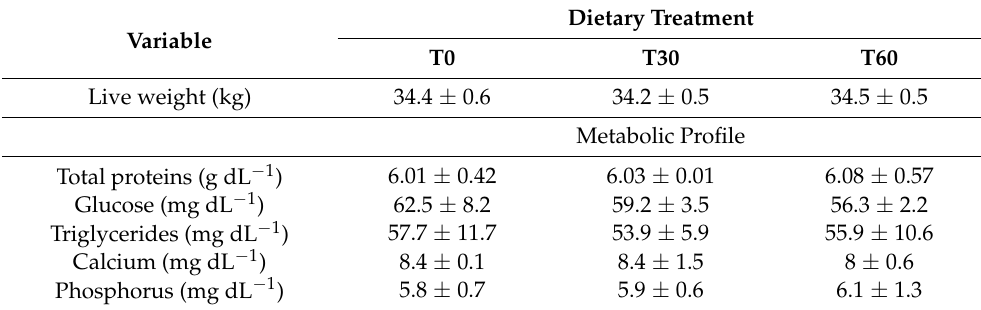
Table 2. Initial ( − 15 d) live weight, metabolic profile, and complete blood count of mixed-breed